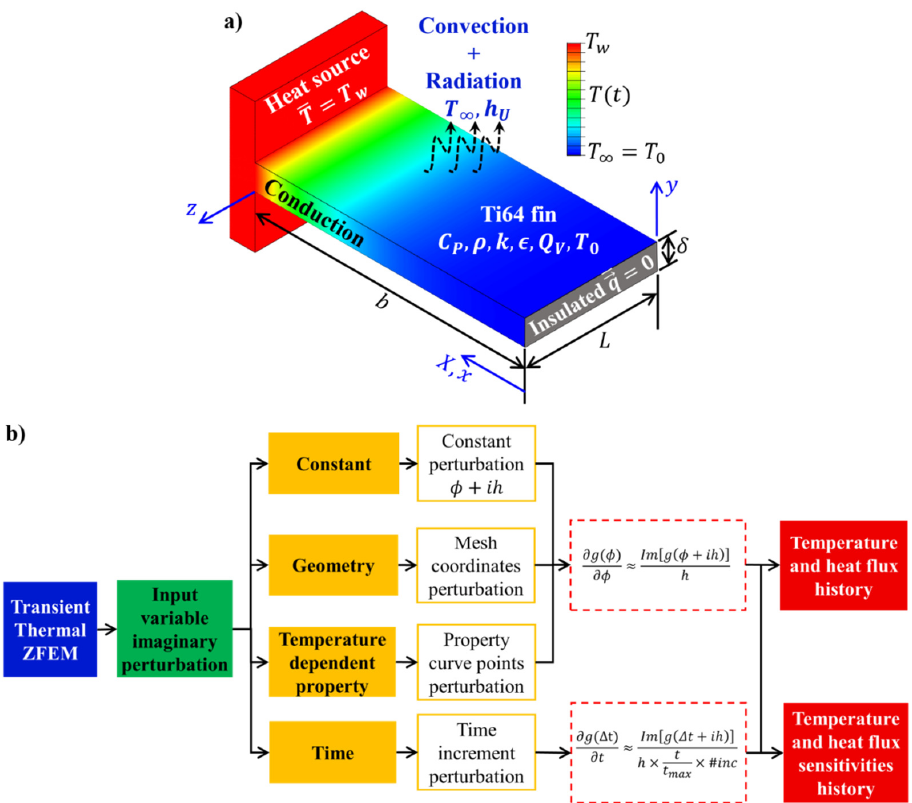
Figure 1. ( a ) Schematic representation of the fin problem, including geometrical parameters and boundary conditions. The colormap represents the steady-state solution for a fin with an insulated tip subjected to room conditions with a predefined wall temperature. ( b ) Transient Thermal ZFEM methodology for sensitivity analysis.